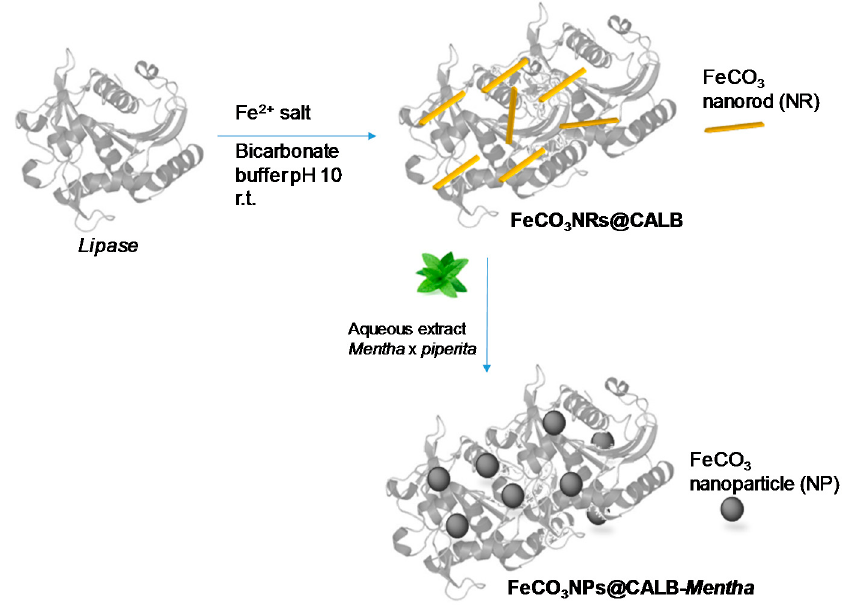
Figure 1. Biosynthesis of the iron carbonate nanorods, FeCO 3 NRs@CALB composites.